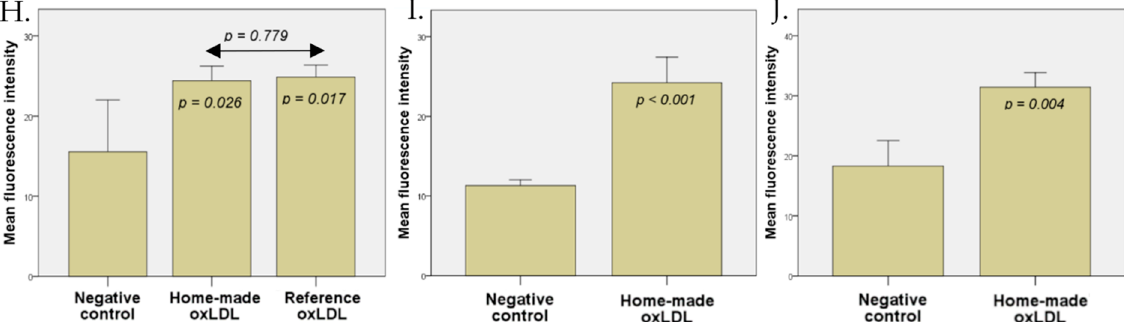
Figure 4. LOX-1 expression on 93VU-147T cells with ( A ) no treatment, with ( B ) home-made oxLDL, or ( C ) reference oxLDL. ( H ) Chart representing LOX-1 expression on 93VU-147T cells with a significant expression both with our home-made oxLDL ( p = 0.026) and reference oxLDL ( p = 0.017) compared to control, but no difference between home-made and reference oxLDL ( p = 0.779) ( n = 10). LOX-1 expression on UM-SCC47 cells with ( D ) no treatment or with ( E ) home-made oxLDL, and ( I ) the chart representing the significantly higher expression of LOX-1 ( n = 10). ( F ) LOX-1 expression on UPCI-SCC154 cells with no treatment or with ( G ) home-made oxLDL, and ( J ) the chart representing the significantly higher expression of LOX-1 ( n = 10).